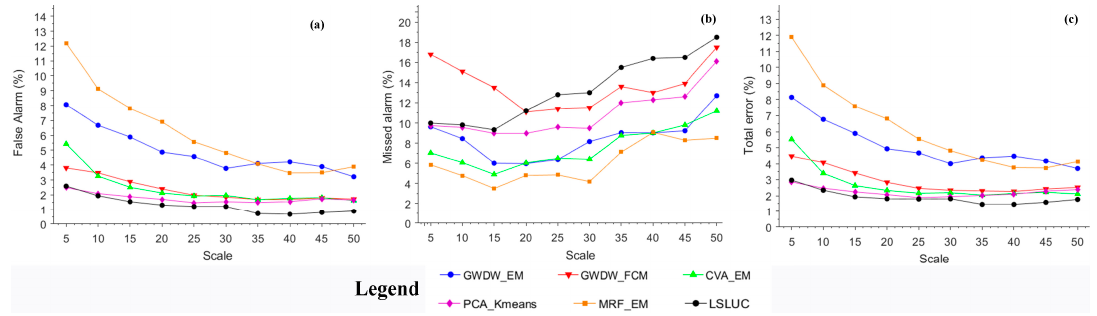
Figure 11. Analysis of the segmentation parameters’ sensitivity for the proposed OBEM post-processing LCCD method with the first data set: ( a – c ) present the relationship between FA, MA, and TE and the parameter scale of FNEA segmentation algorithm, respectively.